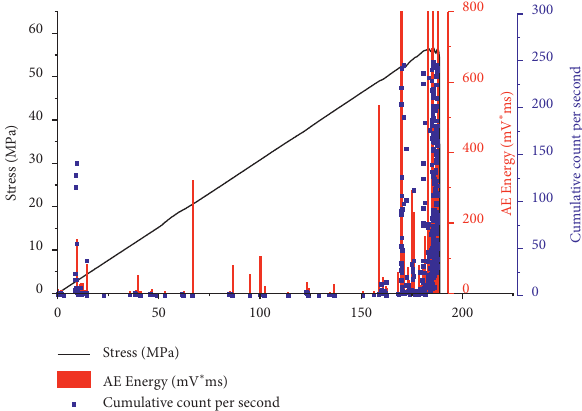
Figure 9: Reliability verification of the predictive